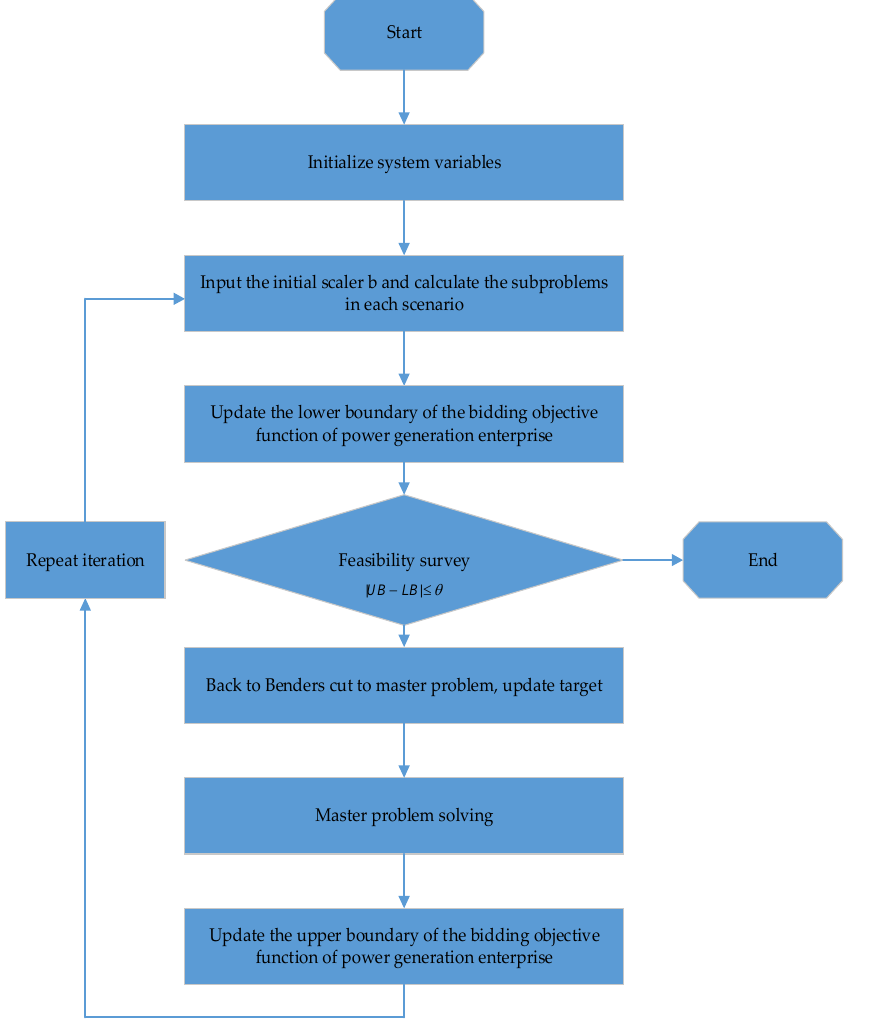
Figure 4. The flow chart to solve the two ‐ stage stochastic optimization model of power generation enterprise bidding based on the improved Benders decomposition method. enterprise bidding based on the improved Benders decomposition